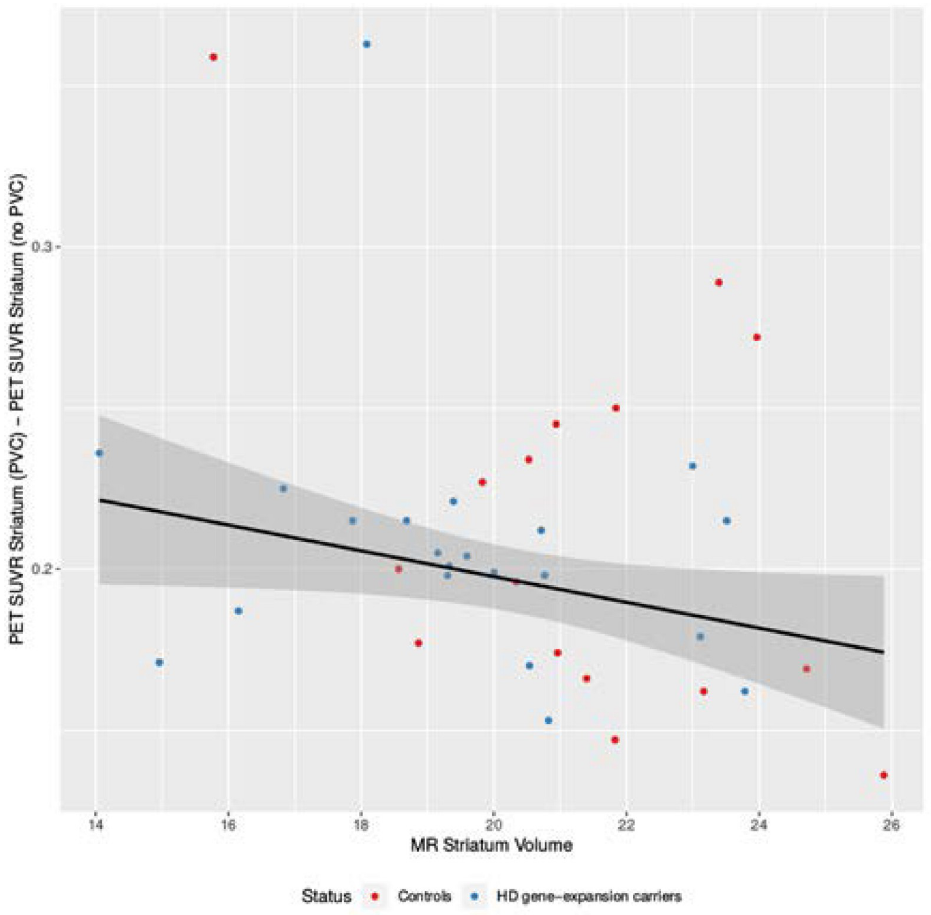
Fig 3. Plot of the difference in striatal 2-[ 18 F]FDG PET SUVR with and without partial volume correction vs. the absolute striatal volume (mL) of both HD gene-expansion carriers (blue dots) and controls (red dots). The slope is -0.023, p = 0.01, one sided. The plot shows that the influence of partial volume correction is largest in objects with the smaller absolute MRI volumes. The variation of differences in striatal 2-[ 18 F]FDG PET SUVR could signify the importance of other factors such as shape and location of the structure that may influence PVC performance. The four top values were eliminated as outliers and not included in the analysis.